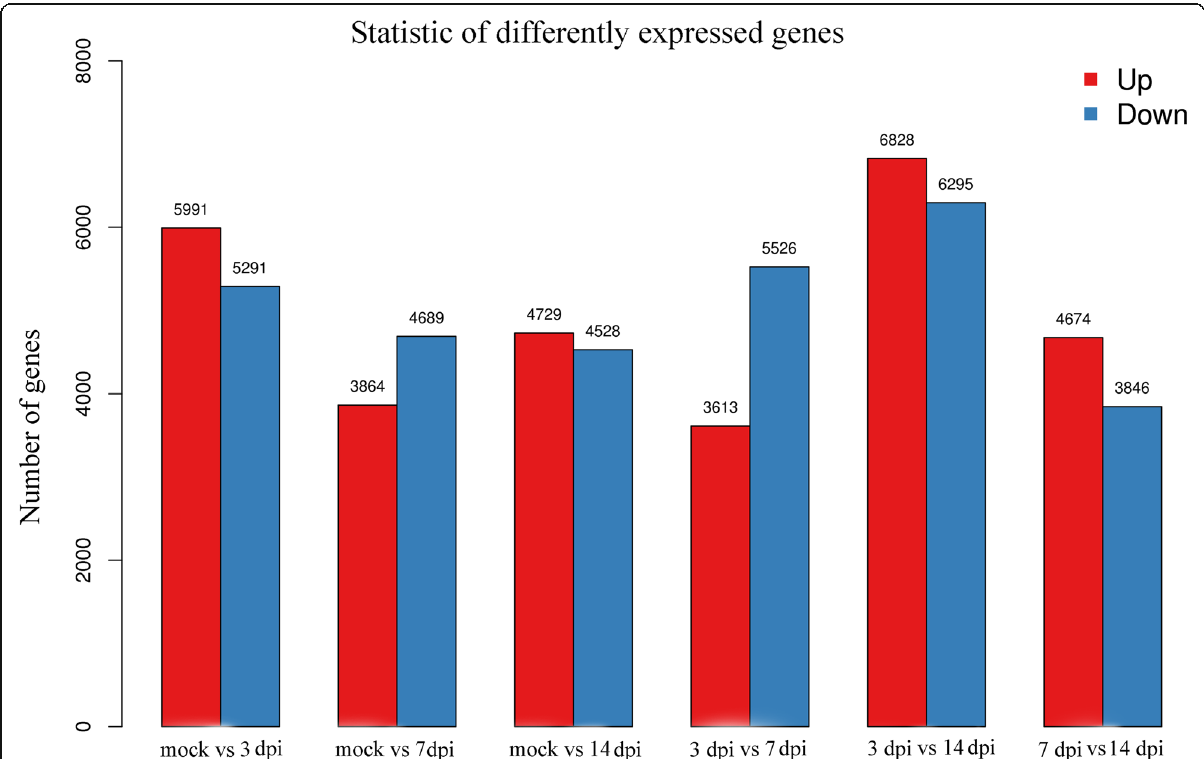
Fig. 4 Identification of DEGs in BYDV-GAV-inoculated P. huashanica at different time points. DEGs were obtained by comparing the BYDV-GAV- inoculated plant samples at 3, 7 and 14 dpi with the mock-inoculated sample, respectively. P. huashanica were inoculated with viruliferous aphids carrying BYDV-GAV, with non-viruliferous aphids-inoculated plants as mock inoculation. For viruliferous aphids-inoculated treatments, the samples were collected at 3, 7 and 14 dpi, respectively; for mock treatment, the samples collected at 3, 7 and 14 dpi were equally mixed to form a composite sample. Bar graph of up- and down-regulated genes from pairwise comparisons (fold change > 2 or < 0.5, and FDR <